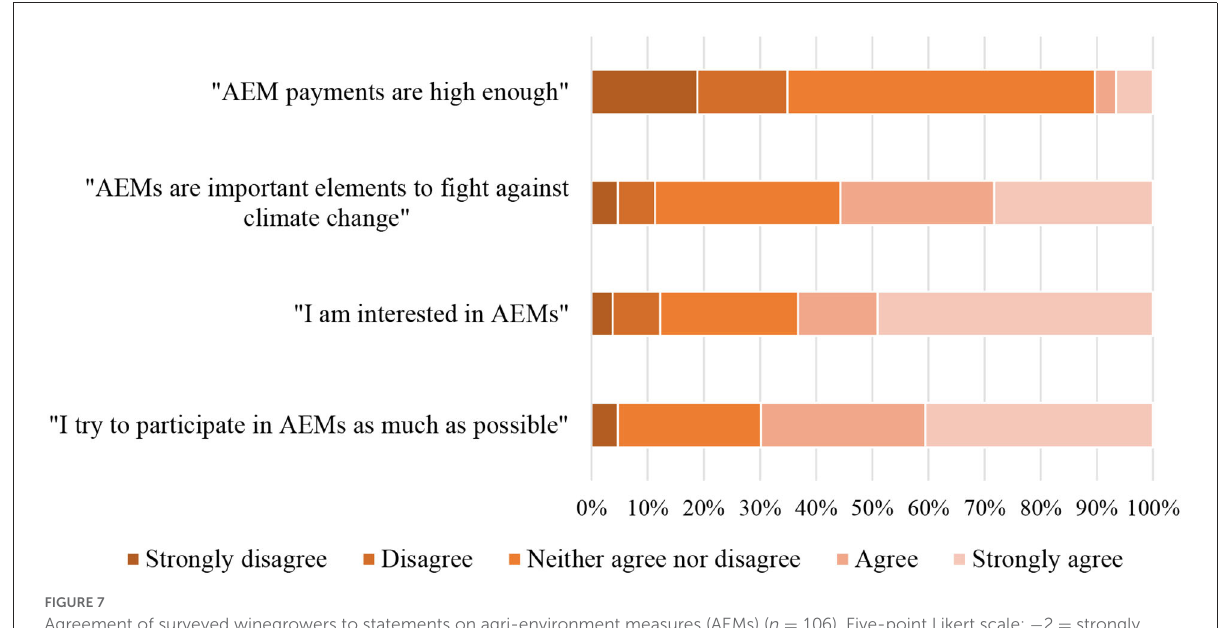
FIGURE7 Agreement of surveyed winegrowers to statements on agri-environment measures (AEMs) ( n = 106). Five-point Likert scale: − 2 = strongly disagree, 2 = strongly